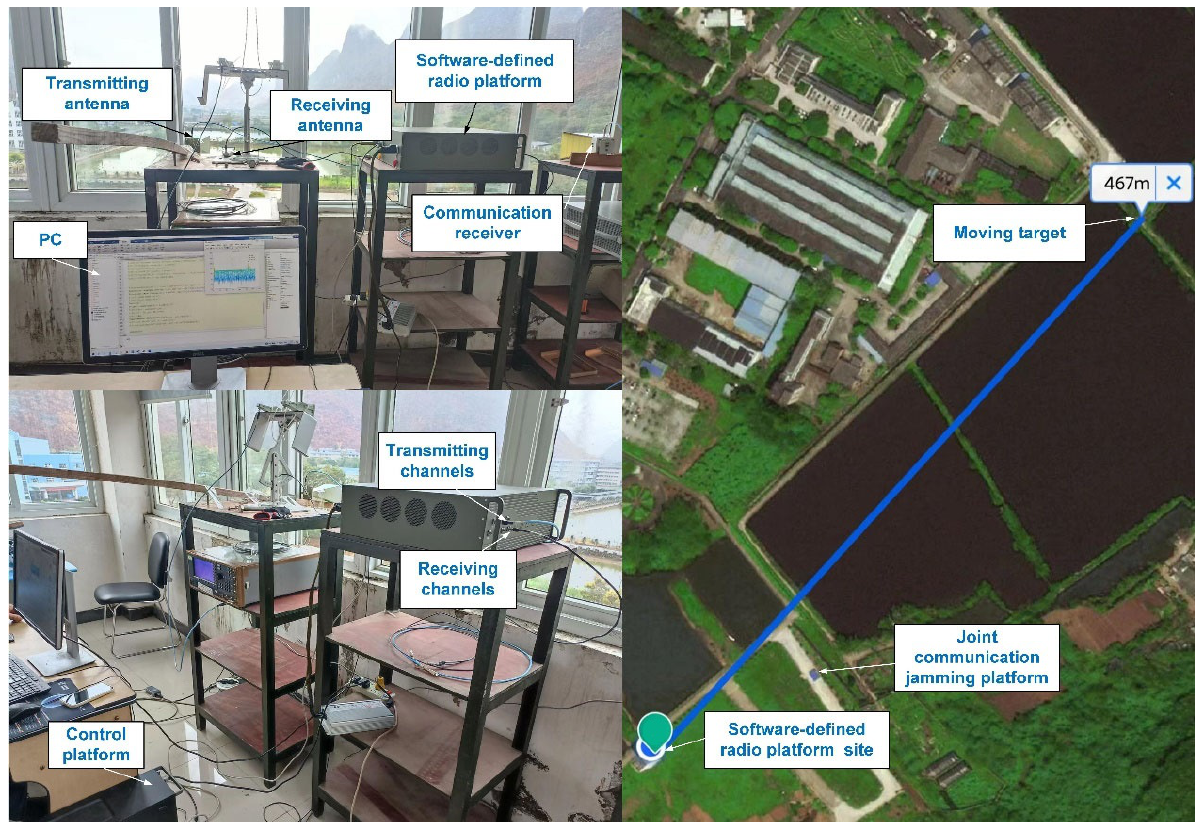
Figure 17. Experimental platform: SDR and spatial position of the experiment.